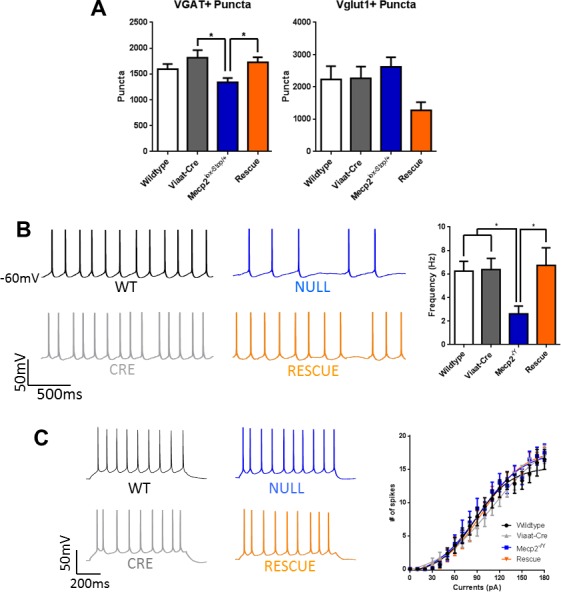
Inhibitory synapse numbers and spontaneous action potential firing are normalized in rescue mice.(A) VGAT+ inhibitory synapses are decreased in the CA1 of Mecp2lox-STOP/Y mice but are normalized in the rescue; Vglut1+ excitatory synapses are not significantly changed in any genotype. (B) Left: Representative traces of spontaneous action potential firing from layer V cortical pyramidal neurons. Right: Summary of spontaneous firing rates across genotypes (wildtype n = 15; Viaat-Cre = 12; Mecp2-/Y = 20; Rescue = 17). (C) Left: Representative traces of intrinsic neuronal excitability. Right: Summary of intrinsic neuronal excitability across genotypes. Error bars show SEM. *p<0.05DOI: